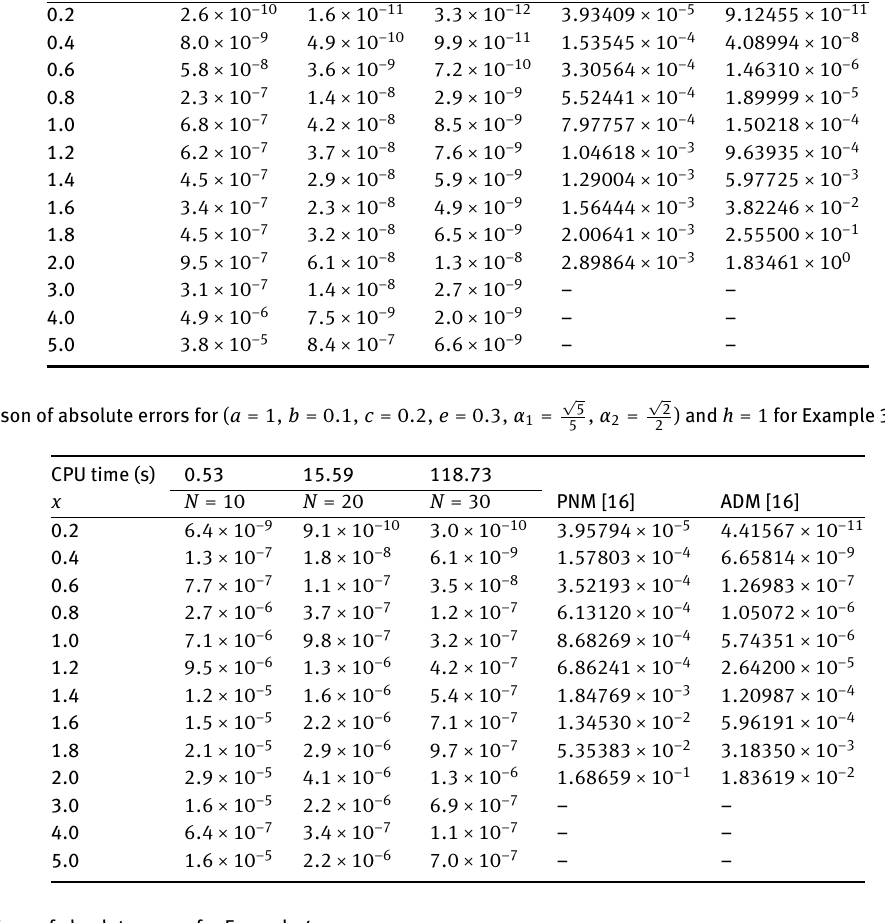
Table 6: Comparison of absolute errors for Example